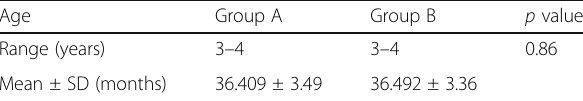
Table 2 Age distribution in among study groups